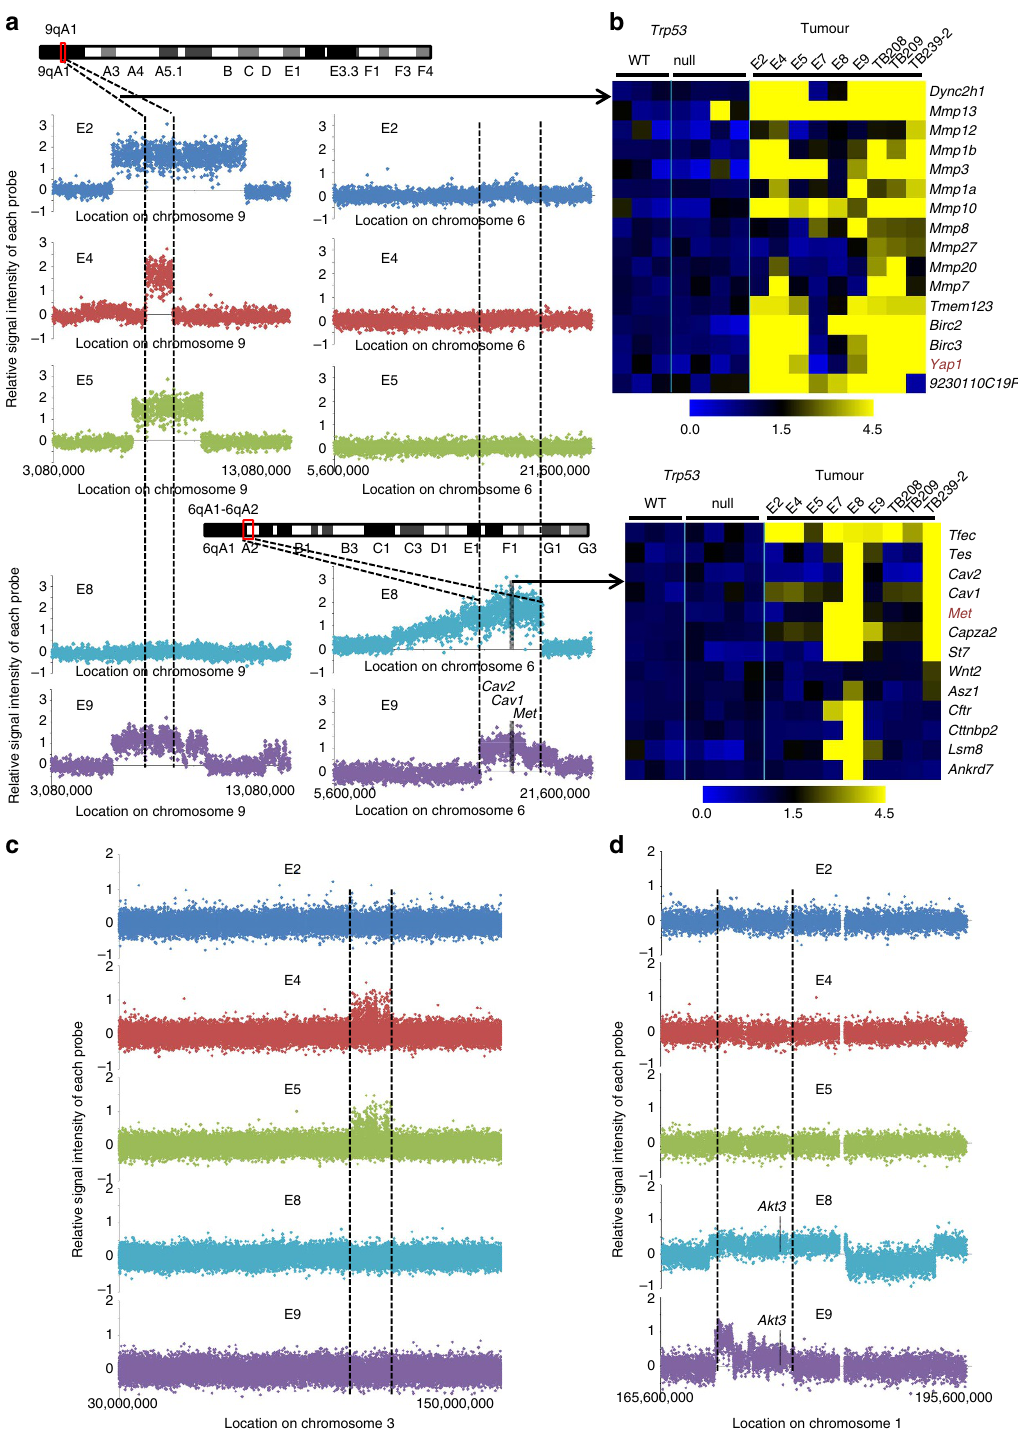
Figure 5 | SNP array analysis showing recurrent genomic lesions in Type 1 and 2 mammary tumours. ( a ) Left: a recurrent genomic lesion ( B 1.15Mb amplicon) on chromosome 9qA1 was identified in several Type 1 tumours (E2, E4, E5, E9). Right: a recurrent genomic lesion (amplicon spanning chromosome 6qA1-6qA2) encompassing Cav2 , Cav1 and Met was identified in tumours E8 and E9. In all plots, relative signal intensity of each probe is shown as the strength of each probe from each tumour sample minus that from the WT control MGs. ( b ) Top: the recurrent 1.15Mb amplicon on chromosome 9qA1 encompasses multiple Mmp and Birc genes, as well as the Hippo pathway-related Yap1 gene; heatmap from microarray confirmed high expression levels of multiple genes (for example, Yap1 ) in this amplicon in tumours E2, E4, E5 and E9 (as in a ); it also revealed several additional tumours (TB208, TB209, TB239-2) with potential amplification of this region. Bottom: the recurrent amplicon on chromosome 6qA1-6qA2 encompasses Cav2 , Cav1 and Met ; heatmap from microarray confirmed high expression levels of multiple genes (for example, Met ) in this amplicon in tumours E8 and E9 (as in a ); it also revealed several additional tumours (E7, TB239-2) with potential amplification of this region. In both heatmaps, expression values were normalized to mean of WTsamples ( ¼ 1). ( c ) A common amplicon on chromosome 3 identified only in a subset of Type 1 tumours (E4, E5). ( d ) A common amplicon on chromosome 1 identified only in tumours E8 and E9. A potential BLBC-related oncogene Akt3 in this amplicon is indicated. NATURE COMMUNICATIONS|8:14431|DOI: